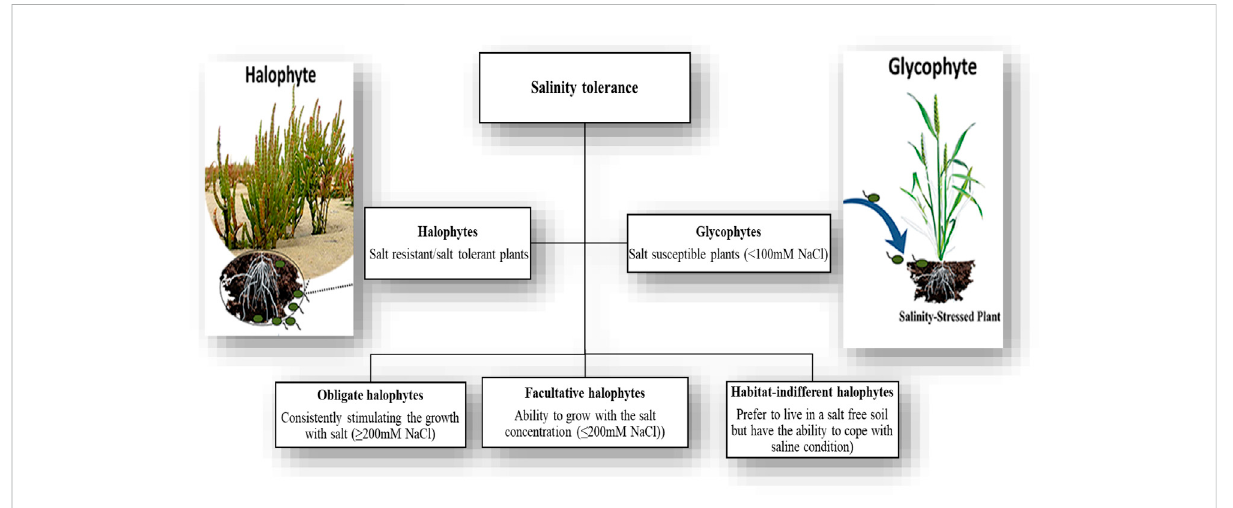
FIGURE 2 Classi fi cation of plants based on salinity stress